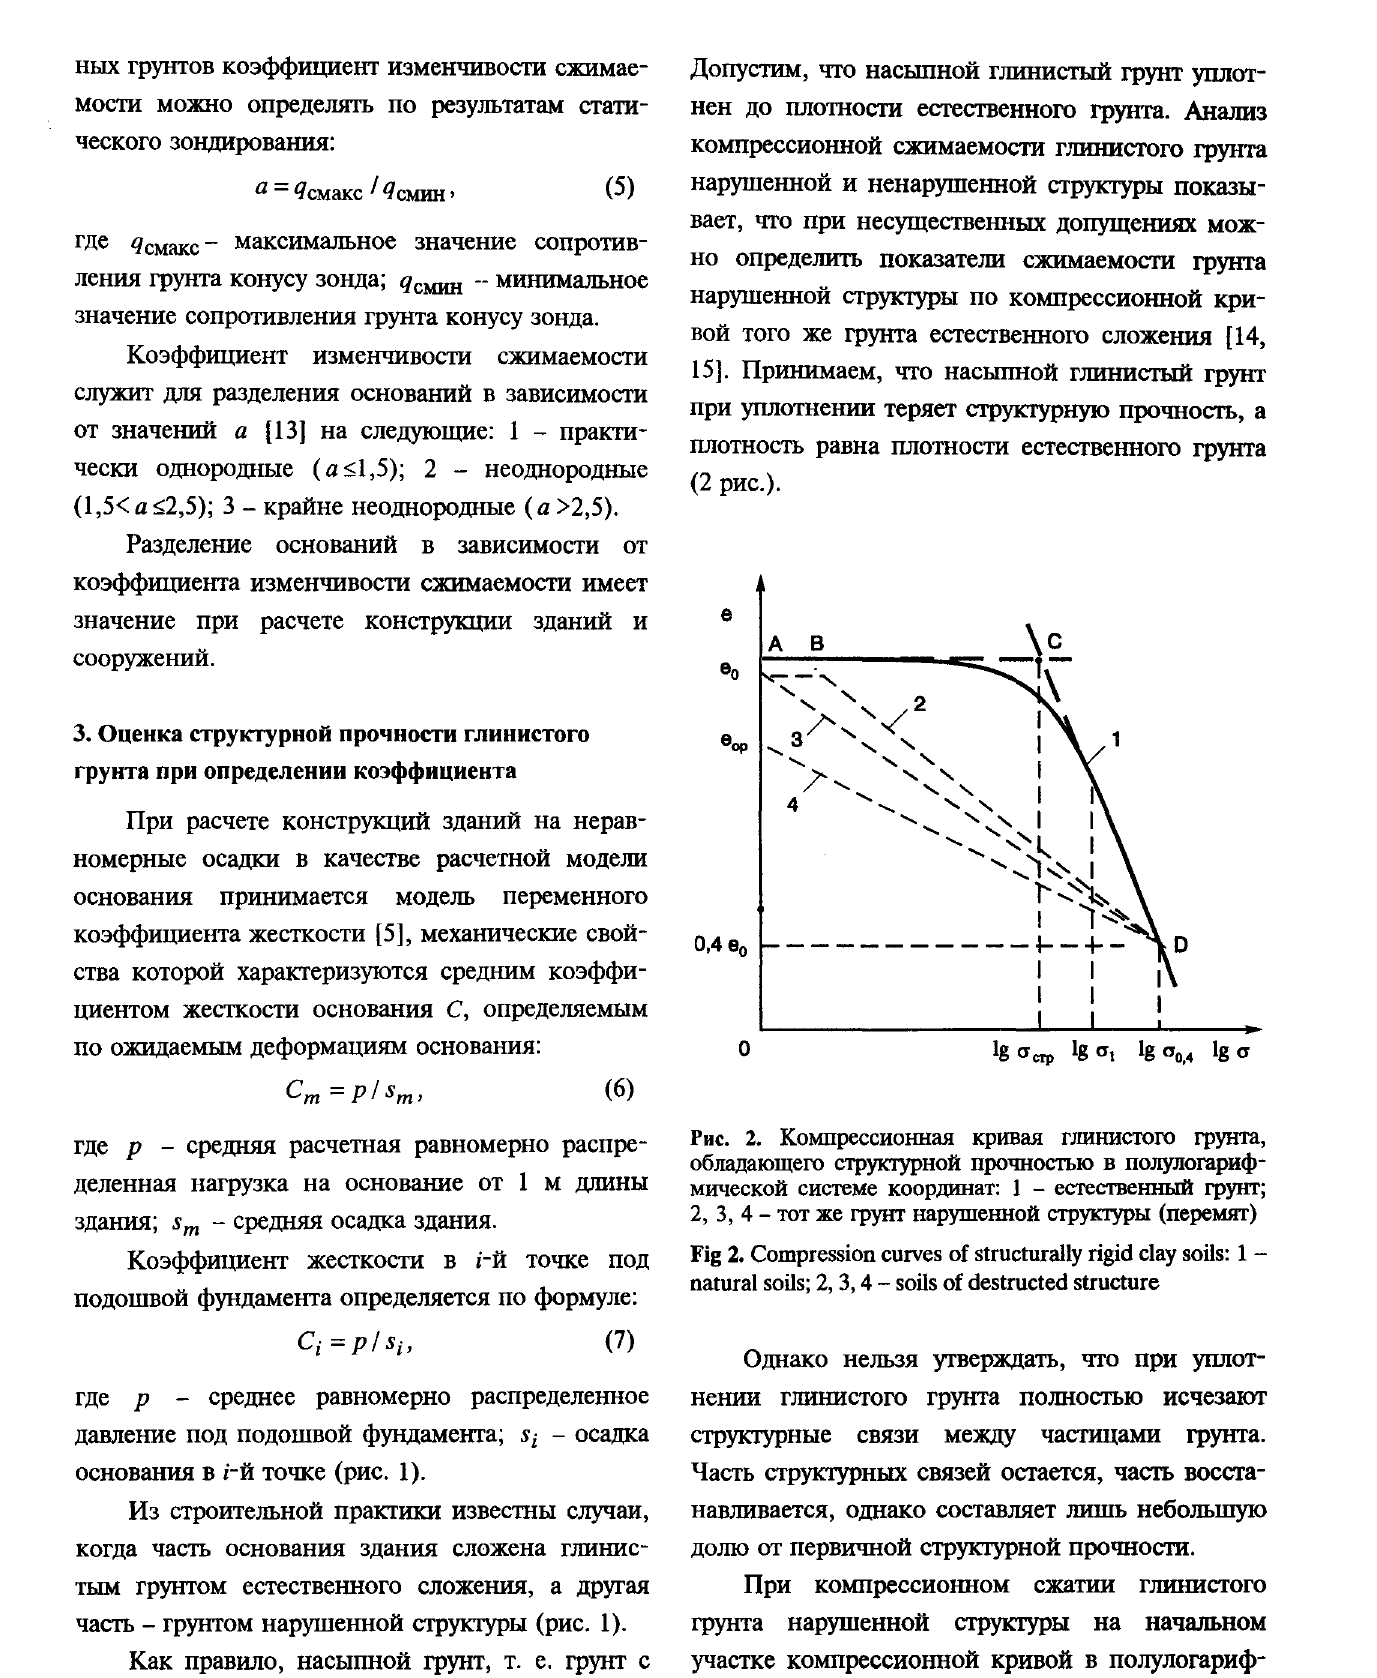
Fig 2. Compression curves of structurally rigid clay soils: 1 - natural soils; 2, 3, 4 - soils of destructed